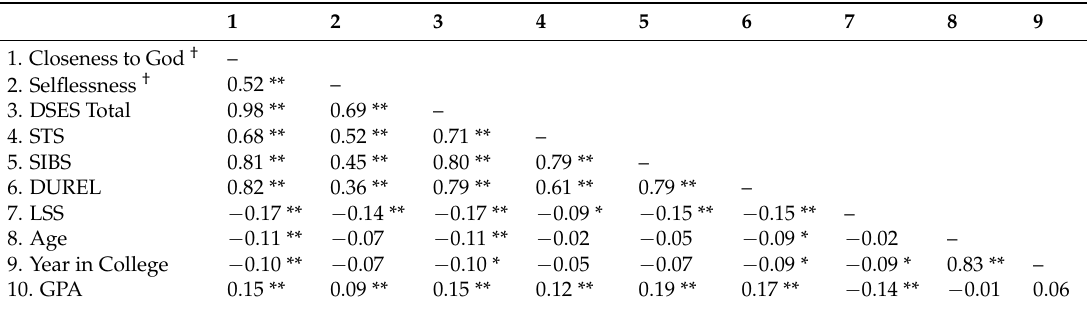
Table 3. Correlation coefficients among Daily Spiritual Experiences Scale (DSES) Components and other included